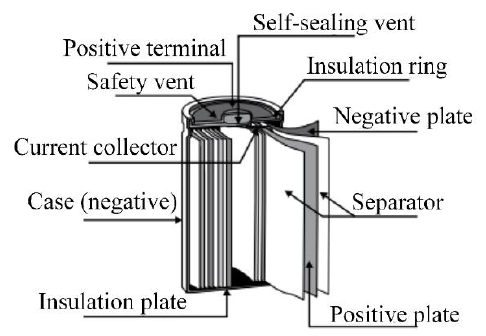
Figure 43. Structural components of a cylindrical Ni-MH battery; the positive electrode consists of nickel oxi-hydroxide and the negative electrode consists of hydrogen absorbing alloys [139].